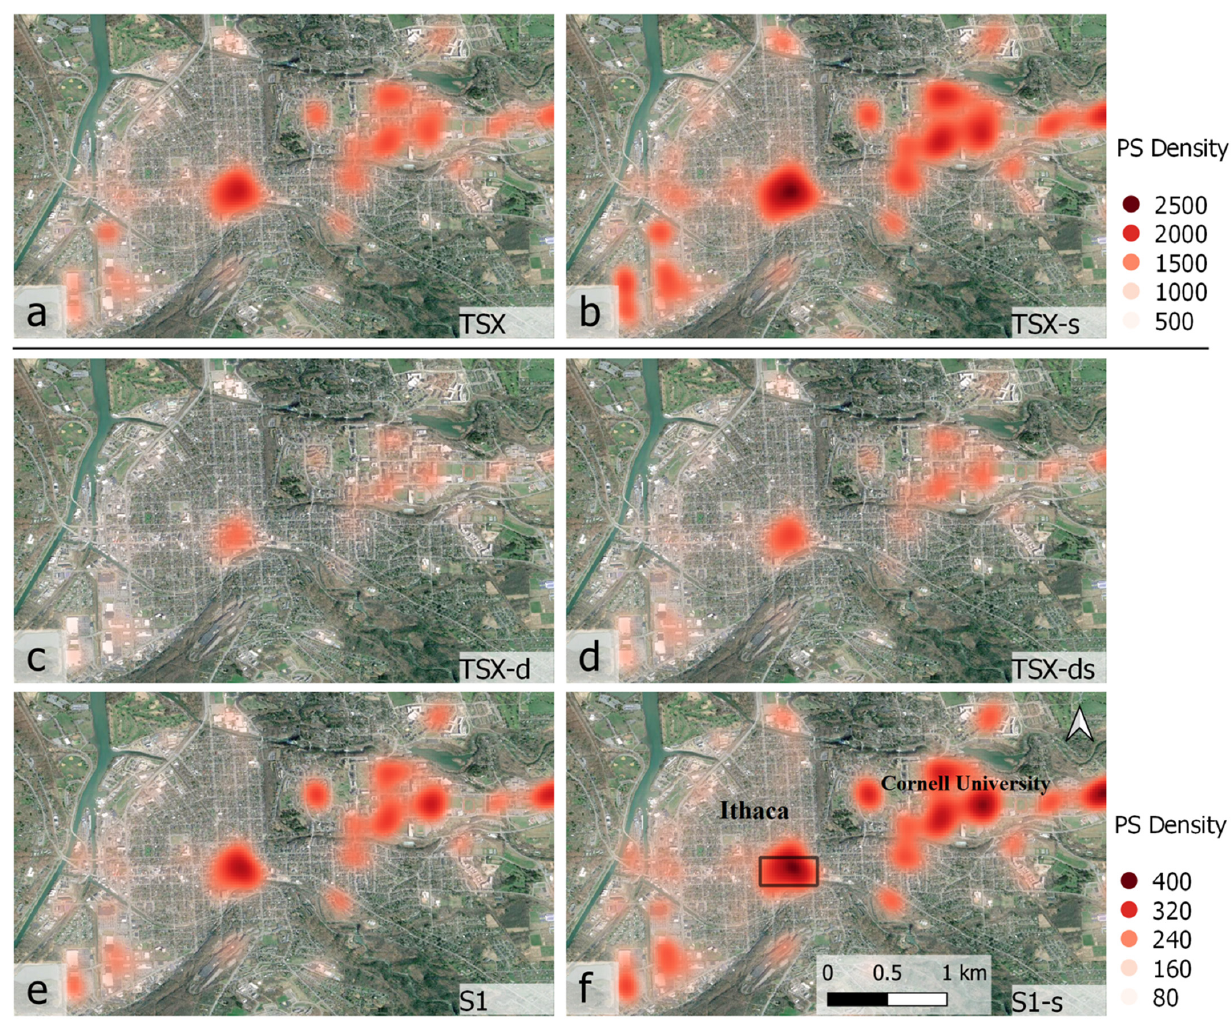
Figure 4. PS density maps extracted using the TSX ( a ), TSX-s ( b ), TSX-d ( c ), TSX-ds ( d ), S1 ( e ), and S1-s ( f ) datasets. The number of PS points over downtown Ithaca (shown as a black box in map f) are given in Table 1. The area shown in this figure is labeled “b” in Figure 1. Basemap imagery available through Google: imagery CNES/Airbus, Maxar Technologies, New York GIS, USDA/FPAC/GEO; map data @2023. Table 1. Number of PS points according to region and dataset.